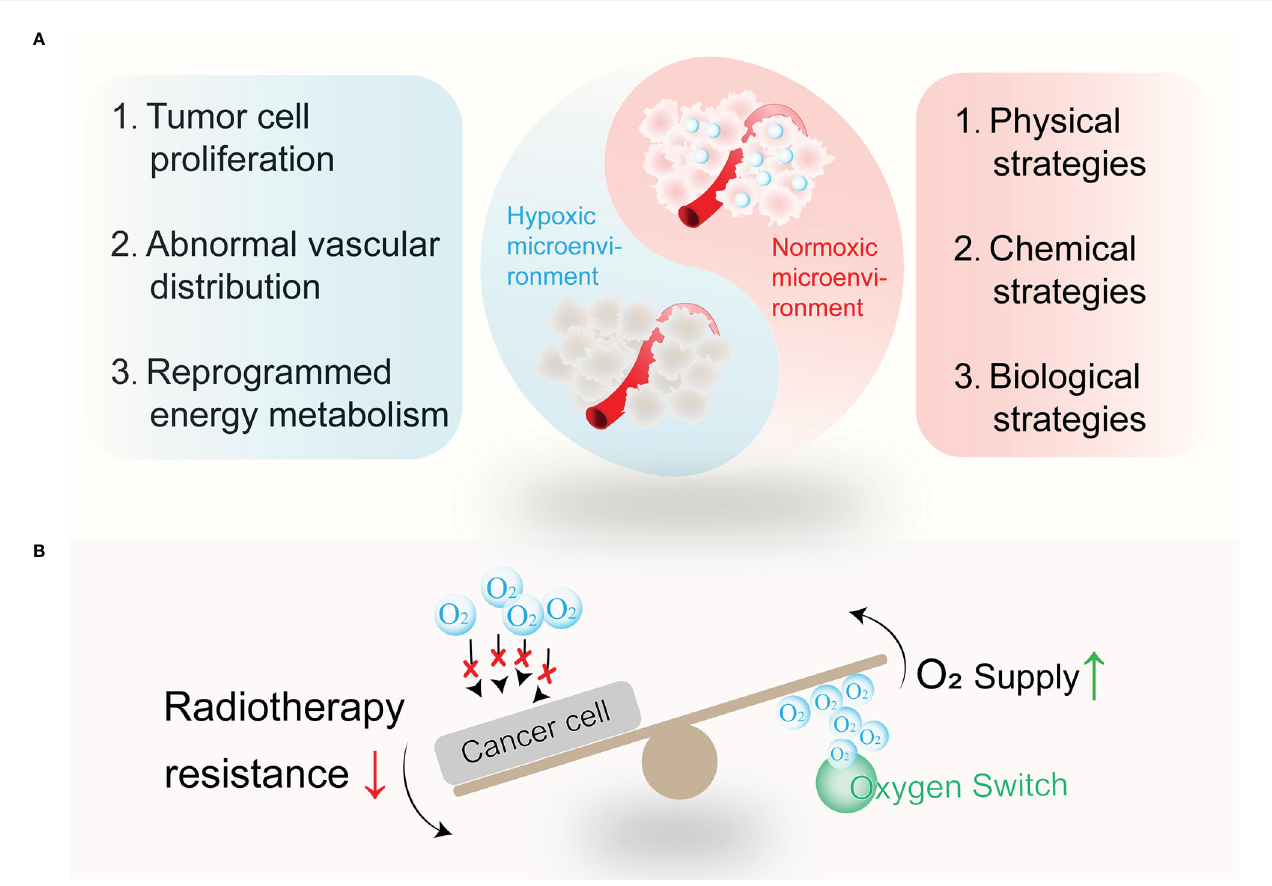
FIGURE 1 The wrestling between tumor hypoxia and related alleviating strategies. (A) Tumor hypoxia remains established for multiple reasons, such as tumor cell proliferation, abnormal vascular distribution, reprogrammed energy metabolism, and so on. Thus, physical strategies, chemical strategies, and biological strategies are designed to relieve tumor hypoxia. (B) Oxygen switches increase O 2 supply or decrease O 2 consumption to combat treatment resistance to